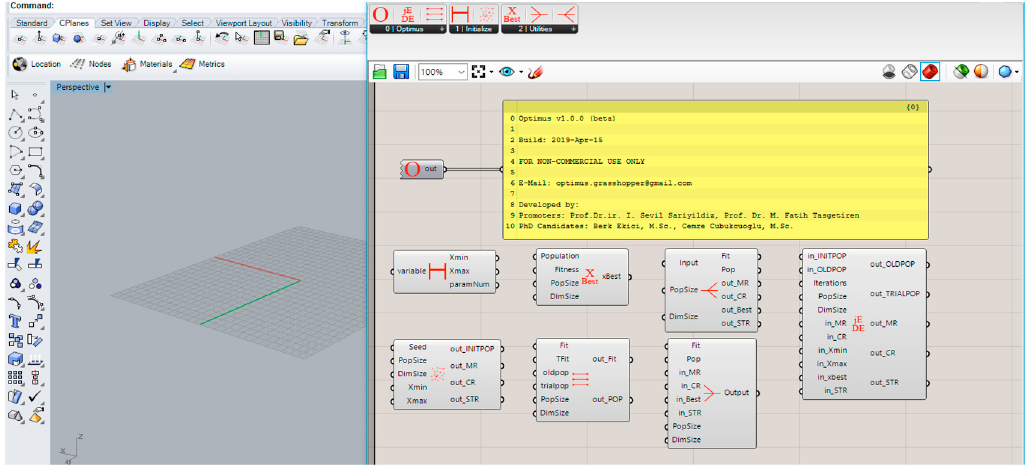
Figure 4. Components of Optimus v1.0.0 (beta).